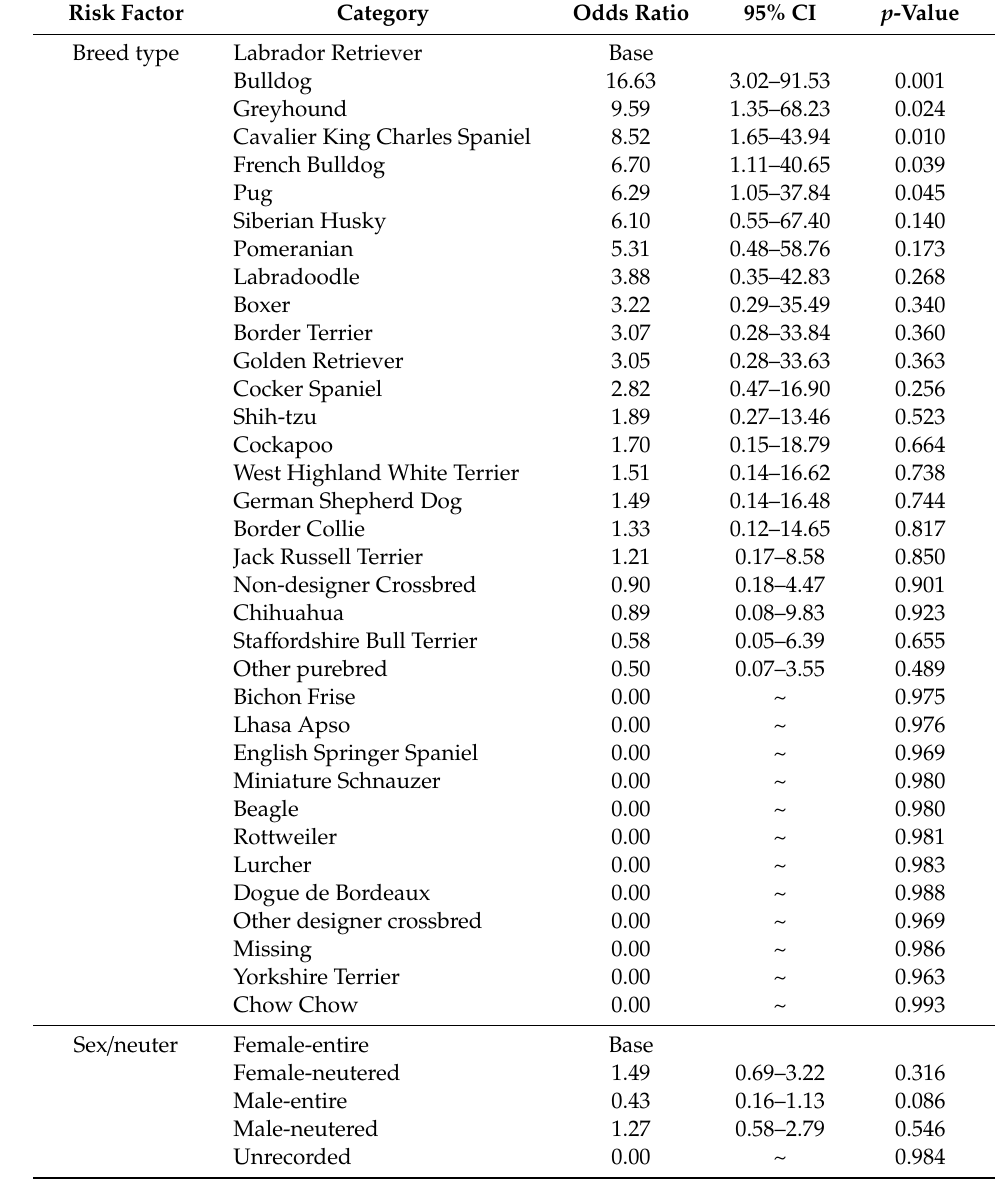
Table 5. Multivariable binary logistic regression results for risk factors associated with vehicular heat-related illness in dogs under primary veterinary care in the VetCompass